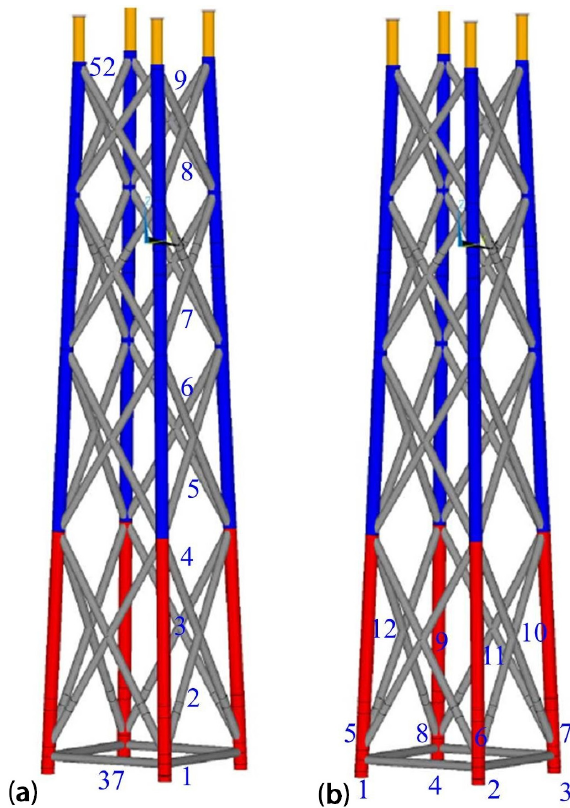
Figure 18. Definitions of Member No. ( a ); and Joint No. ( b ).